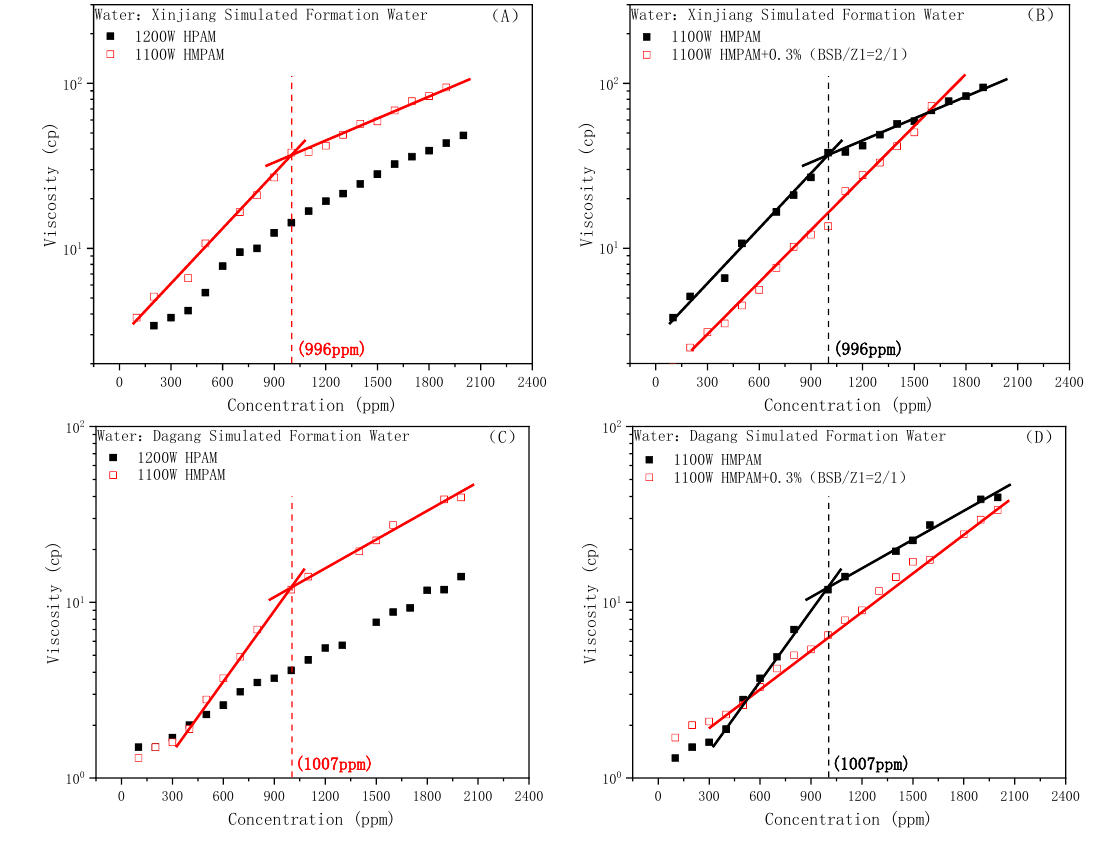
Figure 7. Viscosity of the HPAM and HMPAM solutions under the Xingjiang (weak alkali) condition ( A ). Effect of BSB on the viscosity of HMPAM under the Xingjiang condition ( B ). Viscosity of the HPAM and HMPAM solutions under the Dagang (high salinity) condition ( C ). Effect of BSB on the viscosity of HMPAM under the Dagang condition ( D ).